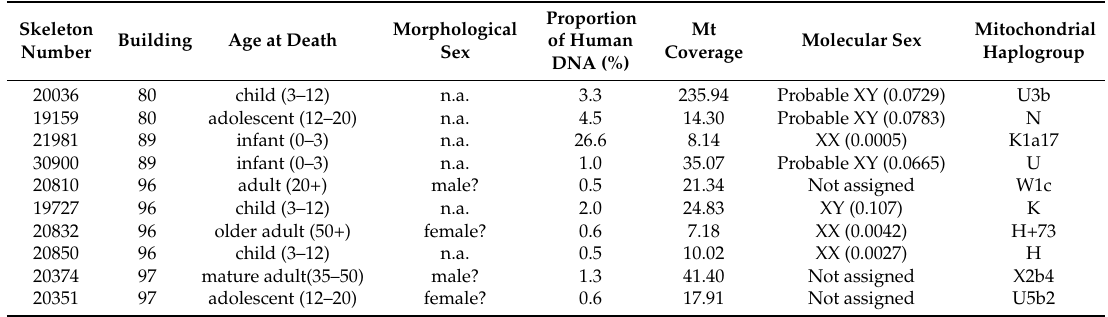
Table 1. Individuals for which the complete mitochondrial genomes were acquired in this study. n.a.: not available, Ry values in